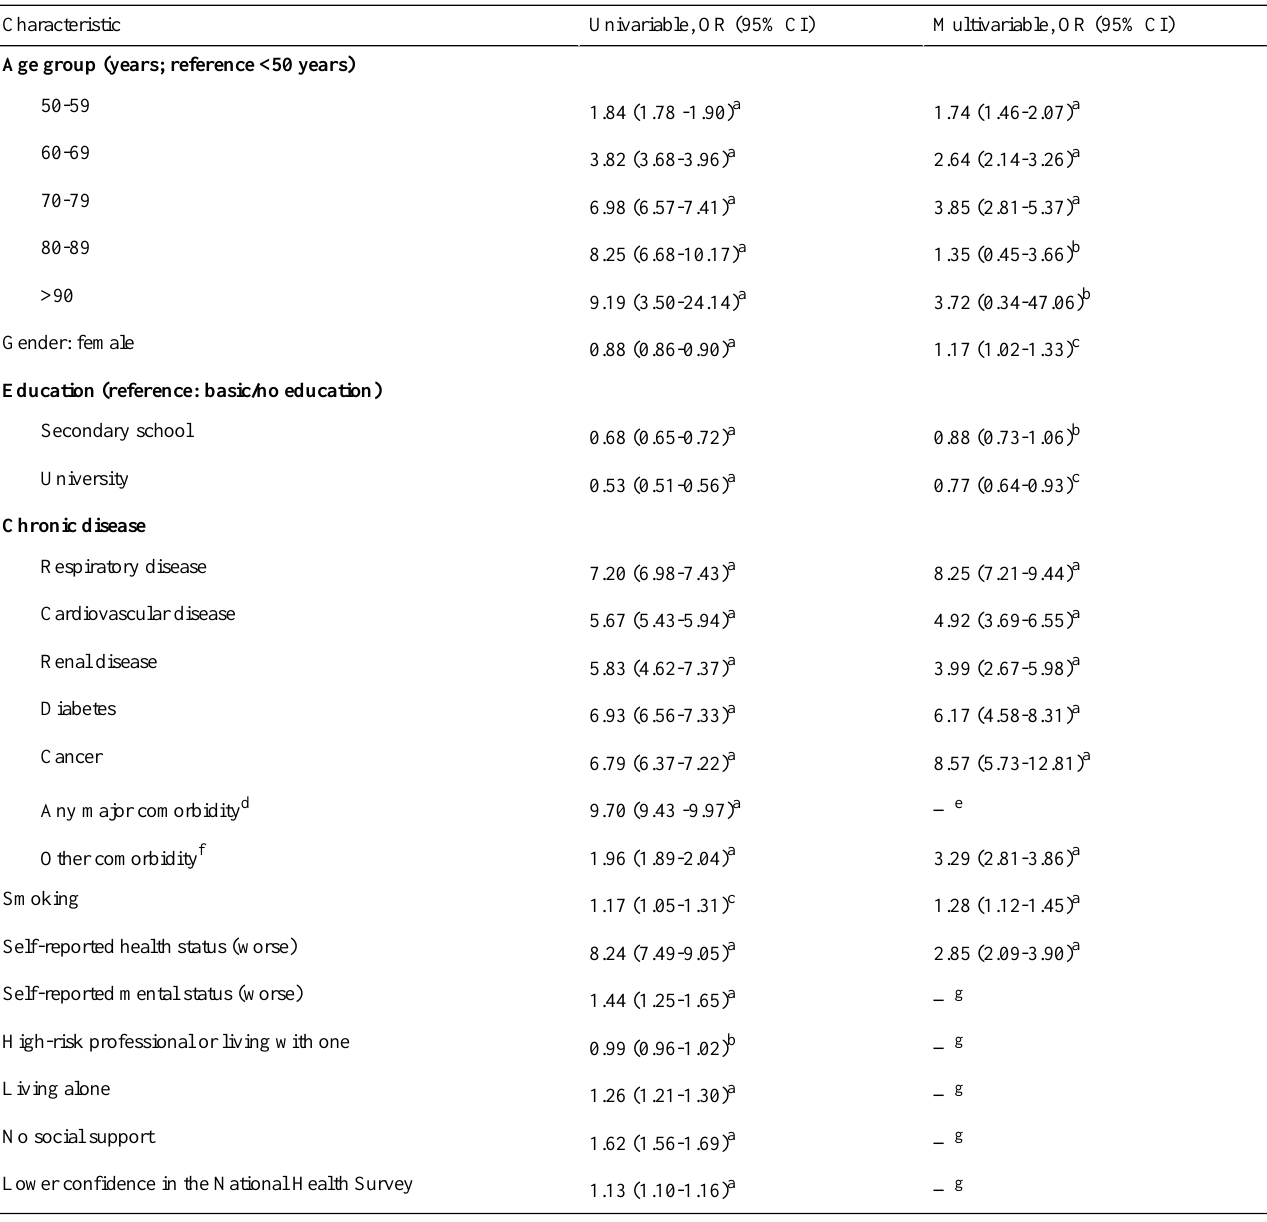
Table 2. Logistic regression (odds ratios [OR] and 95% CIs) to assess the association of chronic diseases with self-perceived risk to develop severe disease following COVID-19 infection